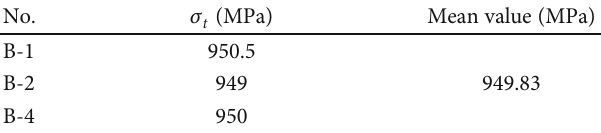
Figure 10: The microscopic features of FOD notch on the No. 7 fl at plate specimen. Table 3: HCF limit of smooth rectangular section